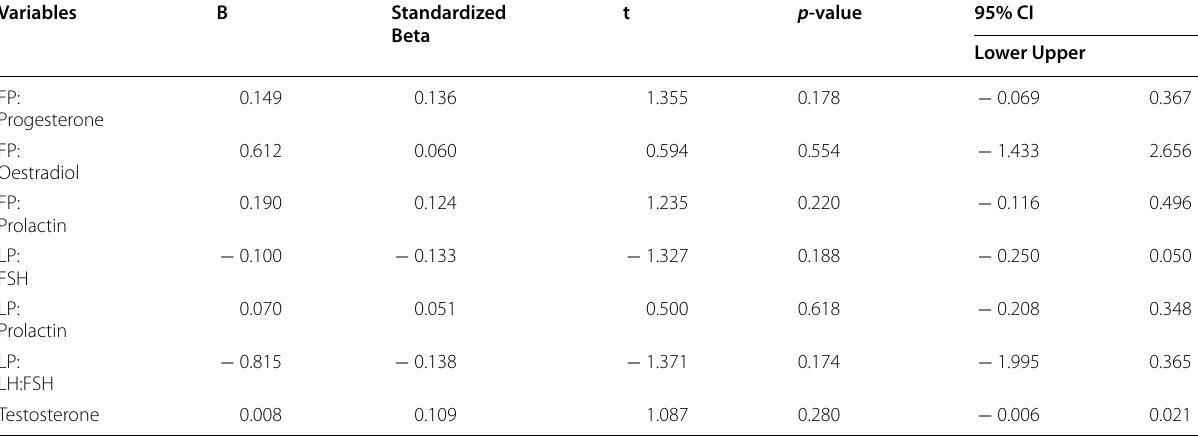
Table 7 Showing linear analysis of the correlates of QOLIE‑TS